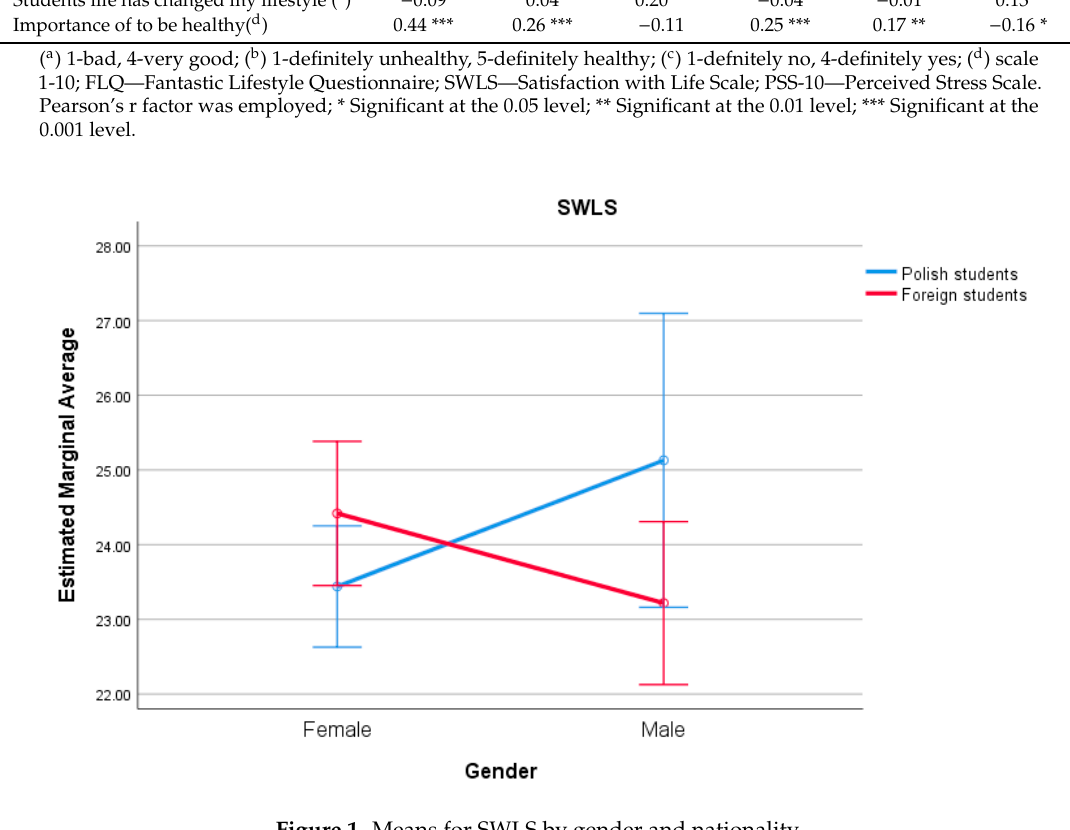
Table 1. Descriptive statistics. Variables